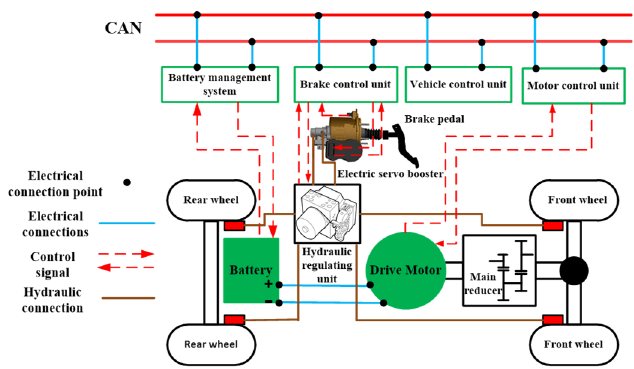
Figure 1. The vehicle con fi guration scheme.